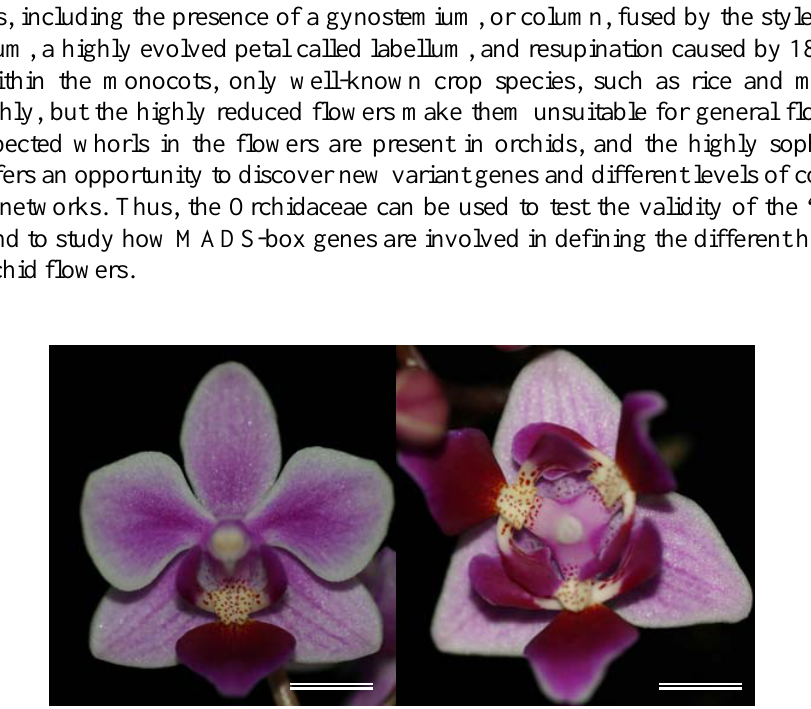
A-CLASS GENES IN